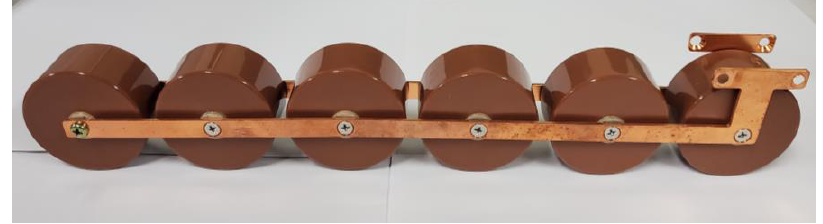
Figure 2. Picture of the six-stage PFN.